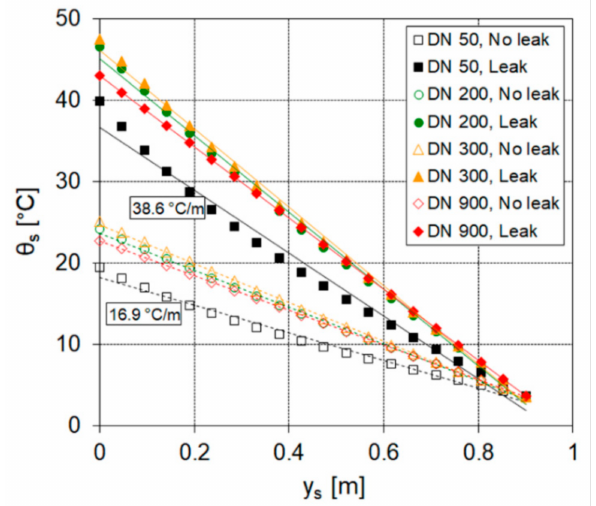
Figure 6. Influence of the channel dimension. DN 50, DN 200, DN 300, and DN 900 refer to Simulation Cases 9, 1, 6, and 10,